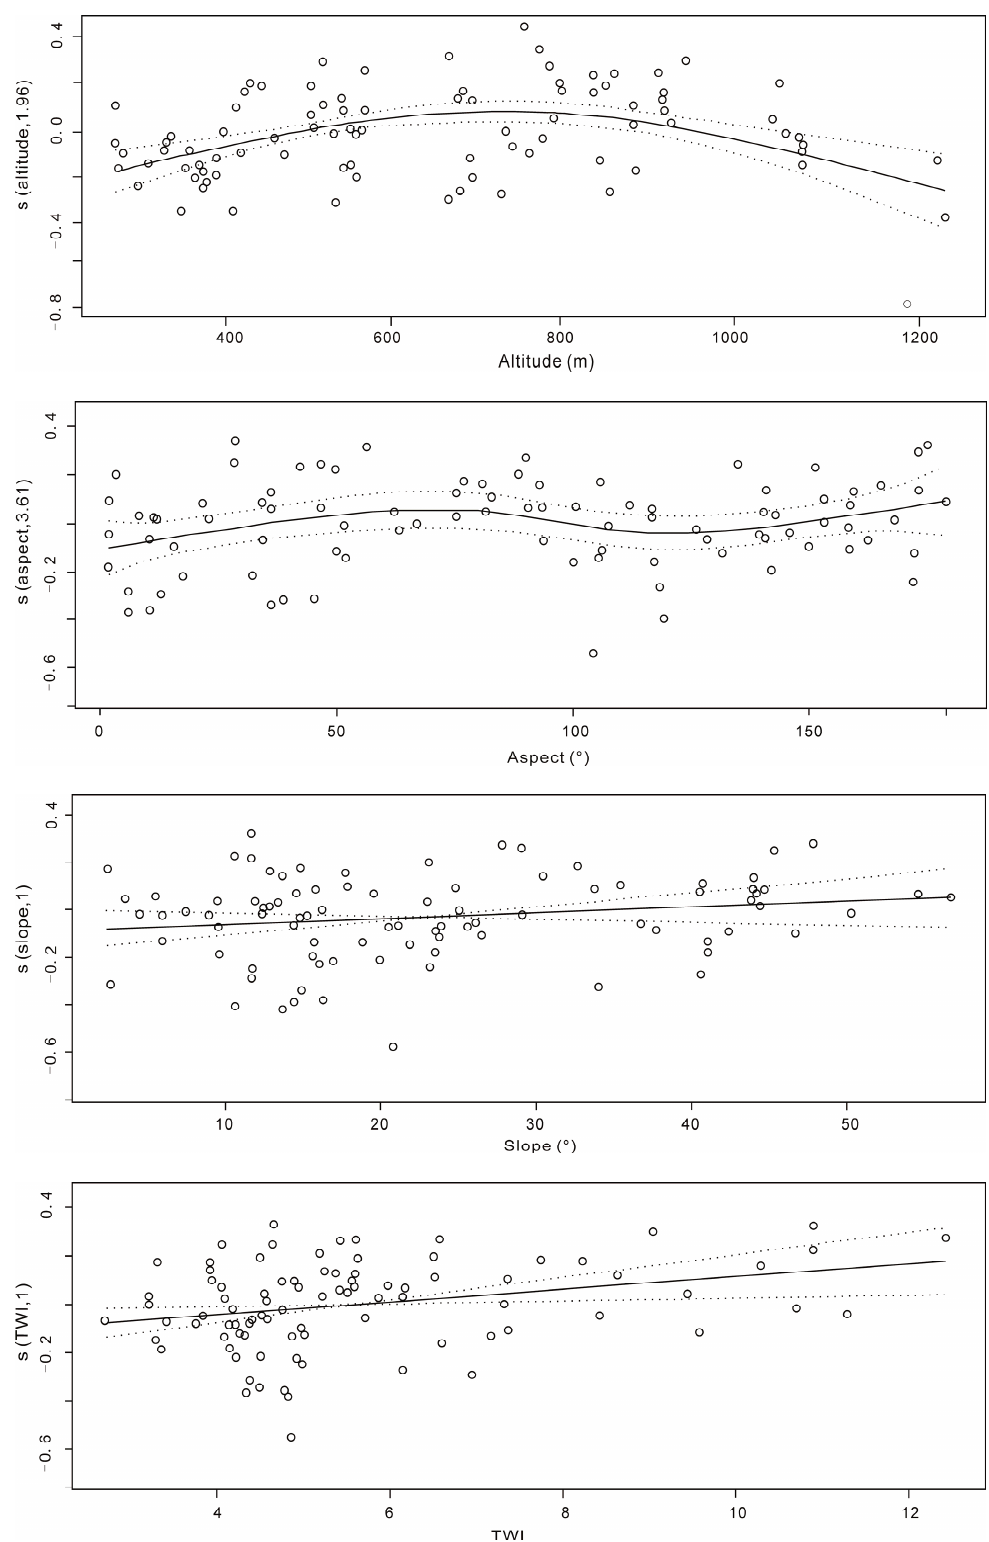
Figure 2. Estimated response curves by GAM, which portrays relations between species richness and topographic variables. Vertical axes are log scaled, based on partial residual and indicate the relative influence of the topographic variable on the estimation of species richness; s is the symbol of the spline smoothing curve; numbers in brackets are the estimated degree of freedom; the dashed line indicates two times the point-wise standard errors for each curve; TWI is the Topographical Wetness Index.